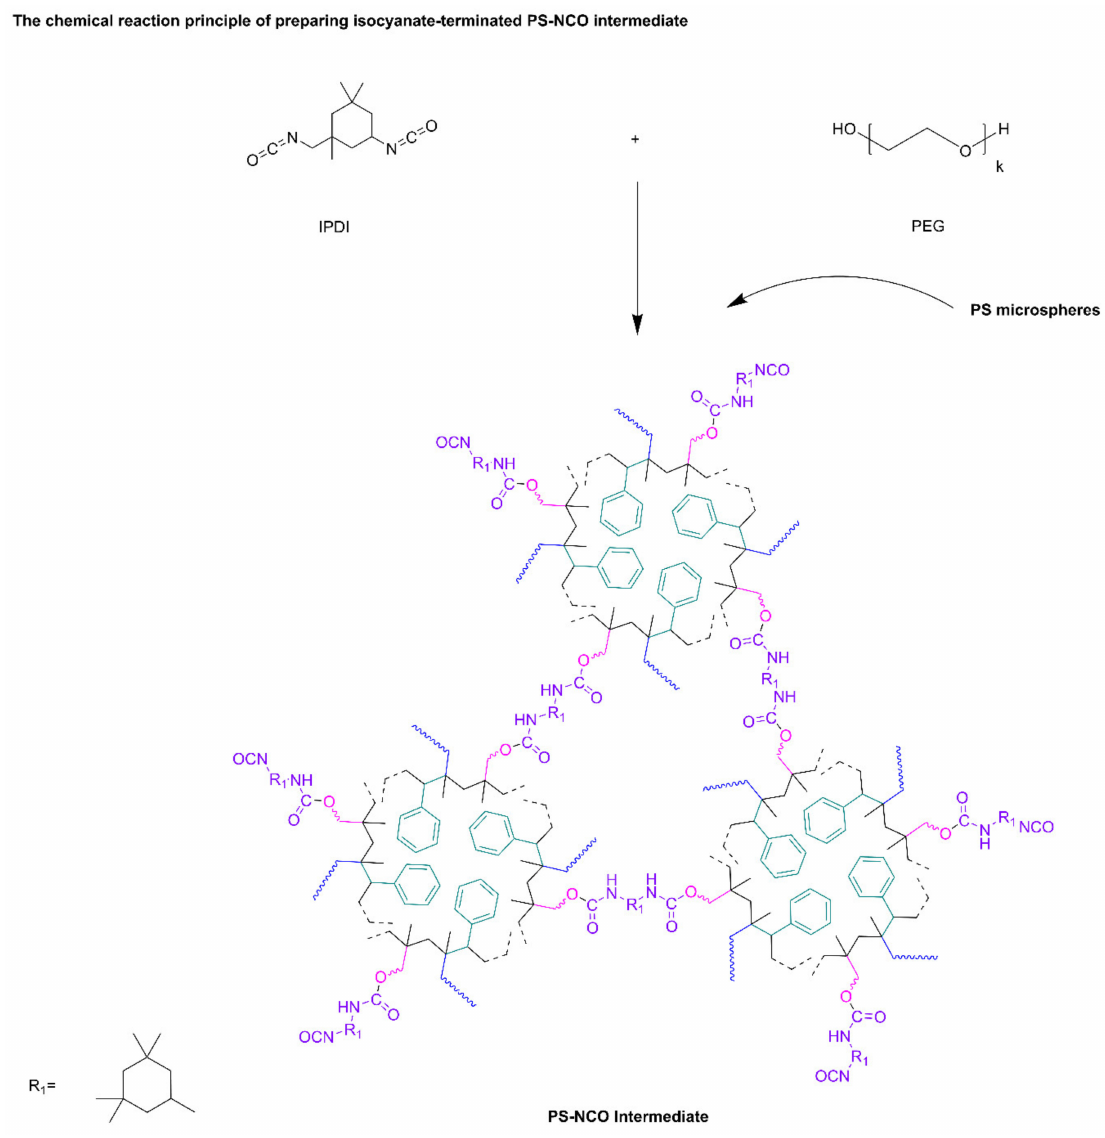
Figure 2. Chemical reaction principle of preparing